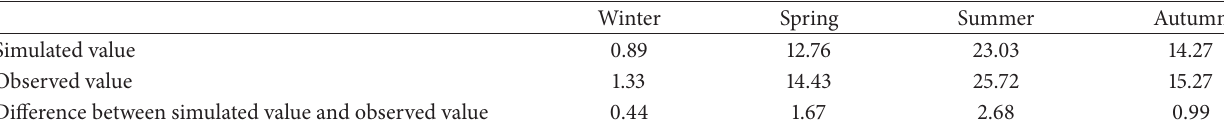
Table 6: Simulated and observed values of the seasonal average temperature at 2 meters above the ground surface in the North China Plain (unit: ∘